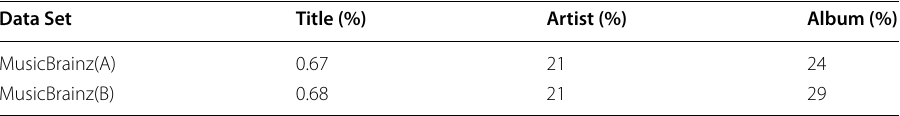
Table 1 Missing values rate in MusicBrainz data sets Data